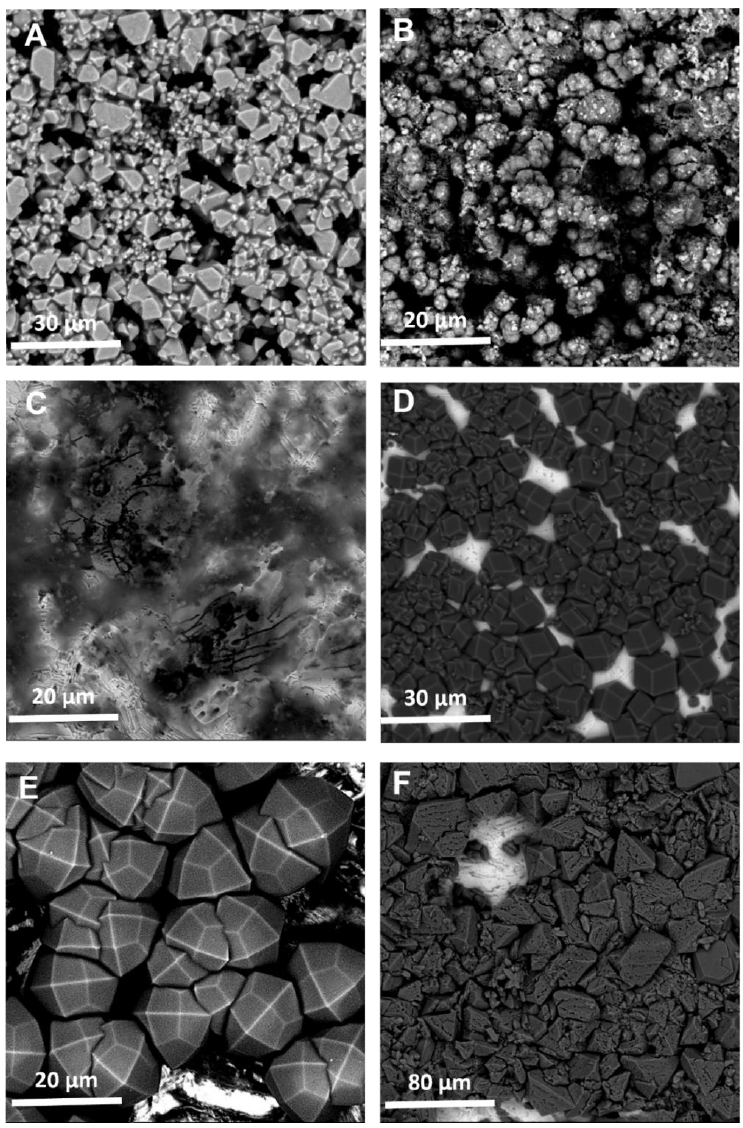
Figure 2. SEM images of the MOF coatings using Cyrene TM as the solvent for: ( A ) Cu and BTC; ( B ) Zn and mIM; ( C ) Zn and bIM; ( D ) Co and mIM; ( E ) Zn and eIM; ( F ) Zn and IM.